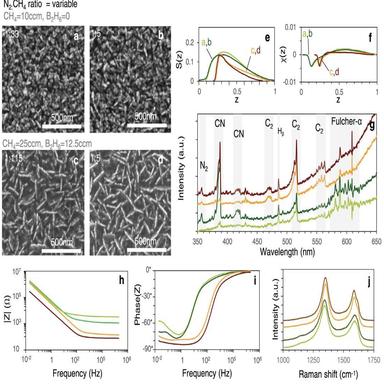
(a–d) SEM, (e,f) MFs, (g) optical emission spectra of the C/N/H plasma, (h,i) EIS Bode plot, (j) Raman spectra of three samples grown at different B-dopings and a variable N2/CH4 ratio.